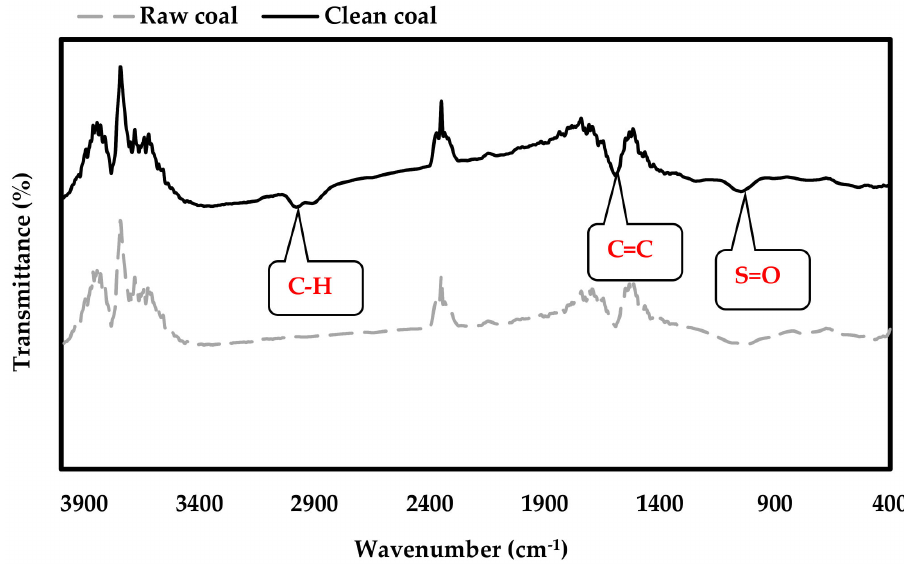
Figure 6. FT-IR analysis of raw coal and clean